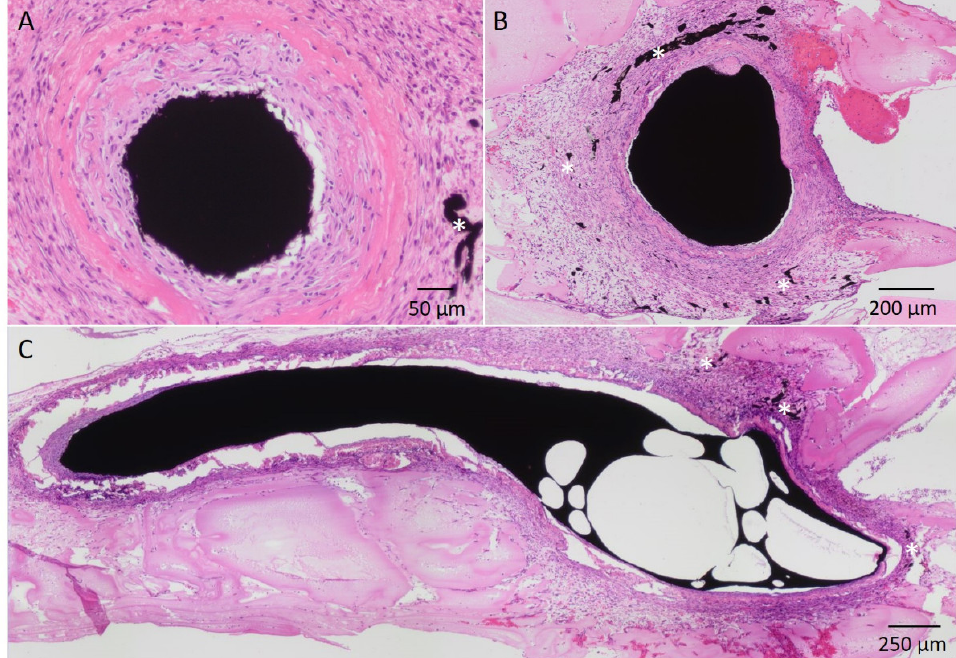
Figure 5. H&E stained sections of a two weeks PCL-collagen I-PEO-construct. Exemplary newly formed vessels are indicated by (*). ( A ): Superficial inferior epigastric artery filled with India ink; ( B ): Superficial inferior epigastric vein filled with India ink, surrounded by newly formed vessels. ( C ): Longitudinal section through the venous interposition filled with India ink, surrounded by newly formed vessels.